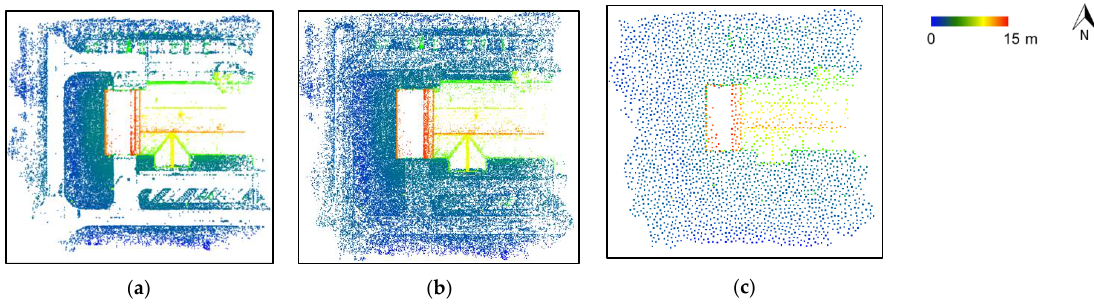
Figure 10. Generated sparse point cloud (colored by height) using ( a ) the default di ff erence of Gaussian (DoG) threshold of 0.007 with 25,000 points, ( b ) smaller DoG threshold of 0.003 with 40,000 points, as well as ( c ) down-sampled sparse point cloud with 3000 points for the A-1